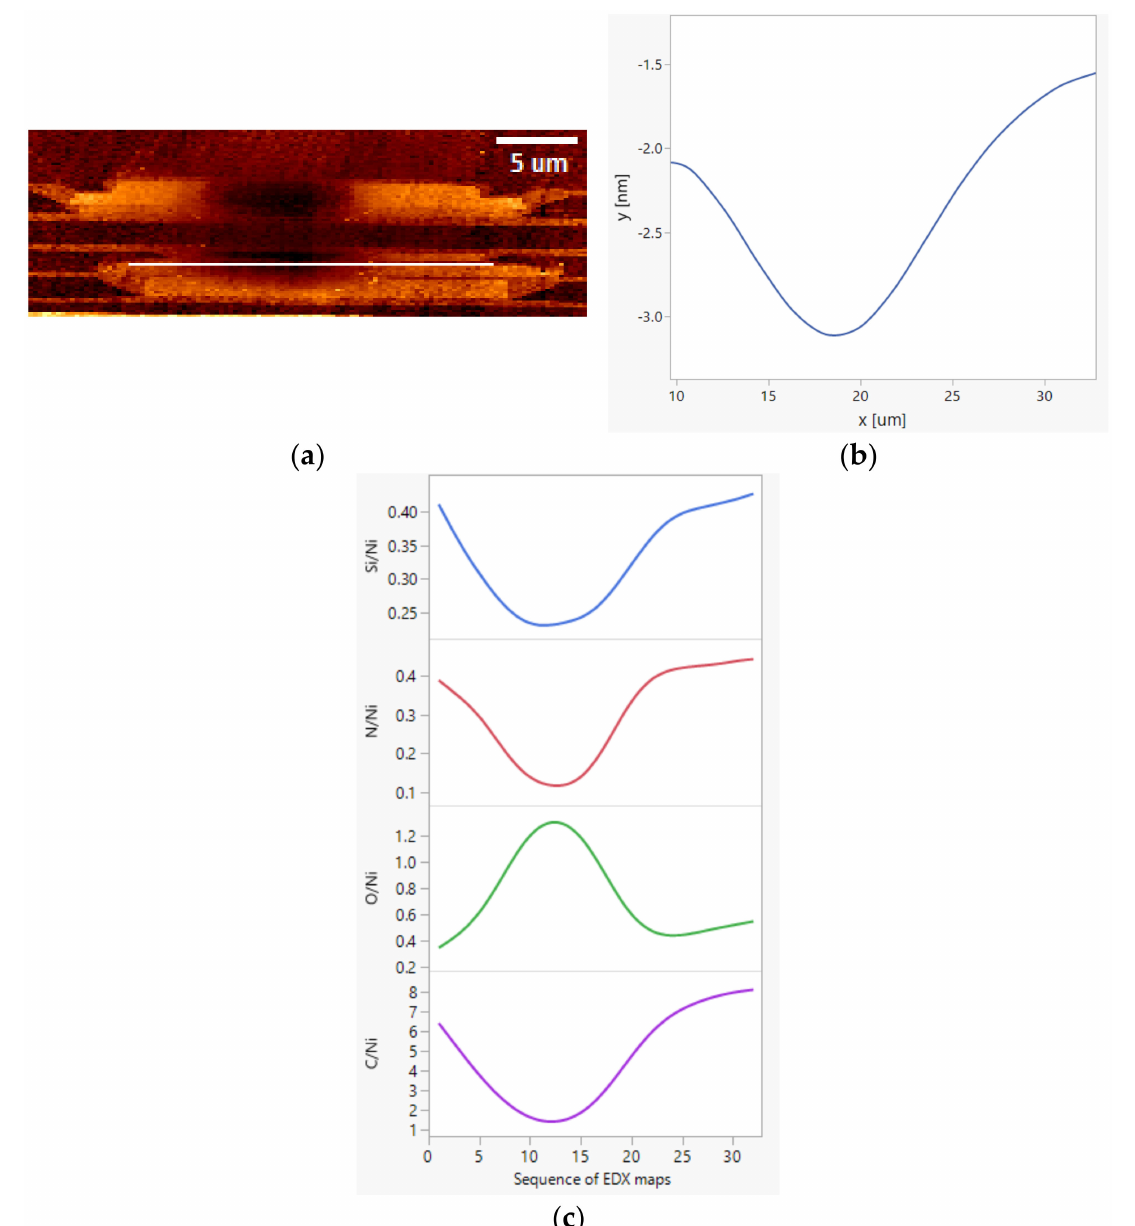
Figure 6. AFM topographic scan of a magnetic head over the reader-writer block ( a ) reveals recessed regions at the NiFe substrate. The corresponding depth profile on the NiFe substrate ( b ) corresponds to decreased C, Si and N, and increased O, as measured by the SEM/EDX technique ( c